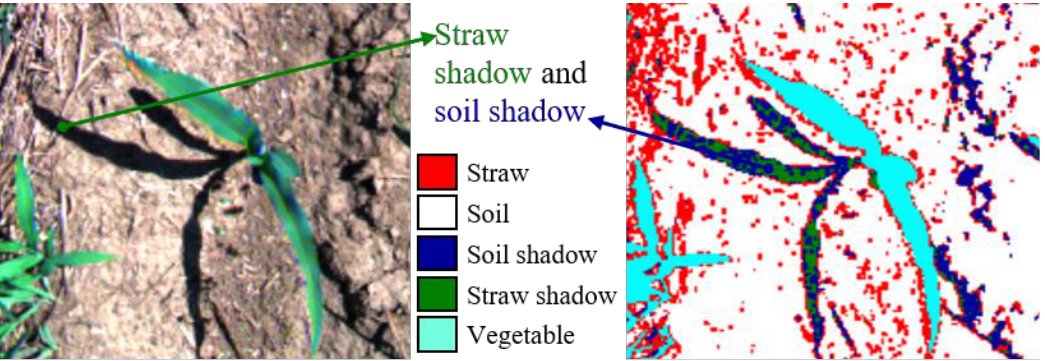
Figure 13. Display of shadow classification error.